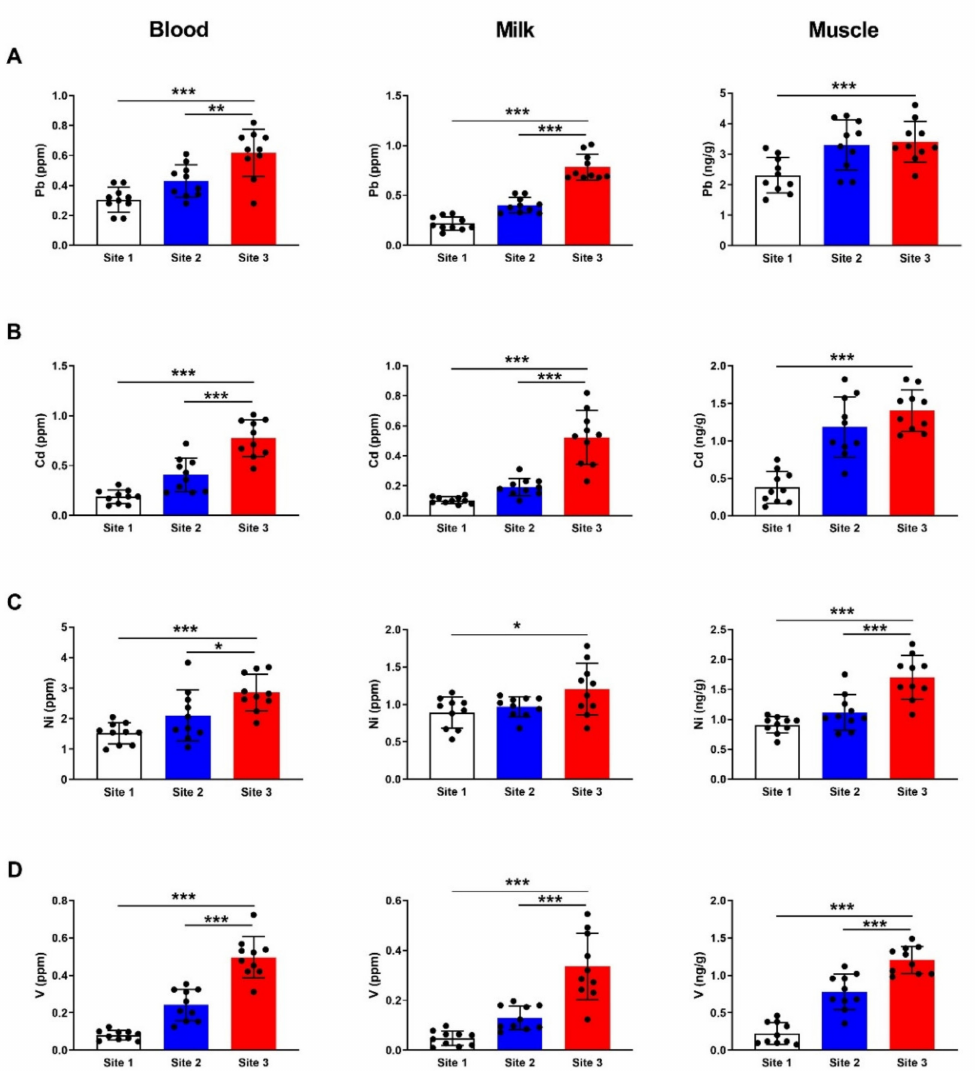
Figure 3. Concentrations of Pb ( A ), Cd ( B ), Ni ( C ), and V ( D ) in blood, milk and muscle of camels at the studied sites. Data are mean ± SD ( n = 10). * p < 0.05, ** p < 0.01 and *** p <